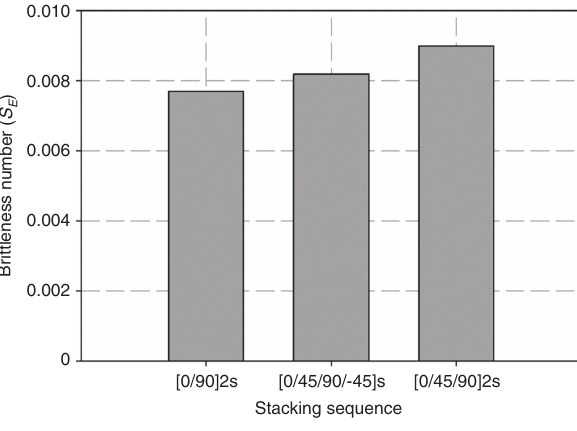
Table 8 Test results for [0/90]